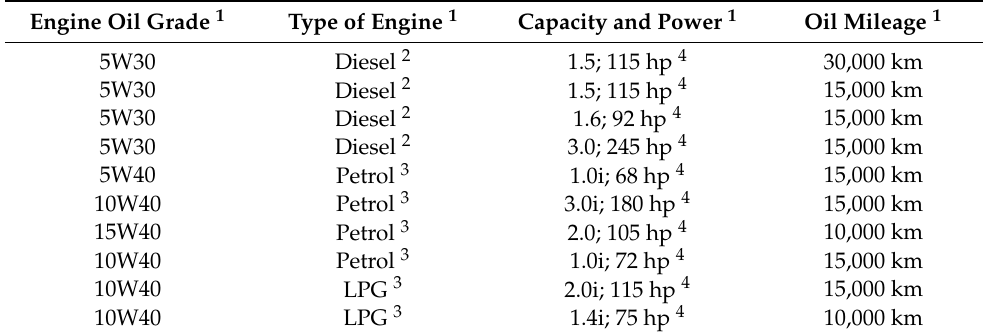
Table 1. Summary of WEOs and the corresponding mileage. Engine Oil Grade 1